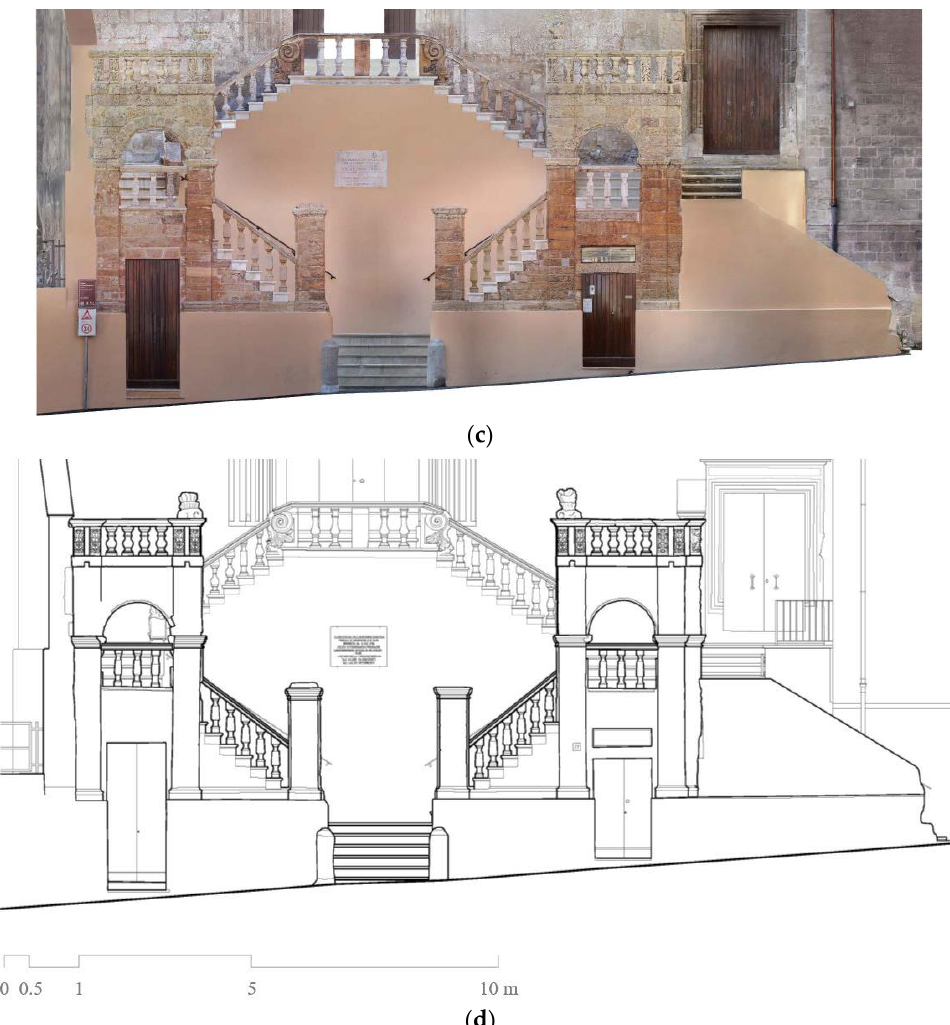
Figure 12. Two-dimensional CAD representation from orthophoto: UAS survey ( a ), 3D processing in SfM software ( b ), orthophoto ( c ), and 2D architectural drawing ( d ).